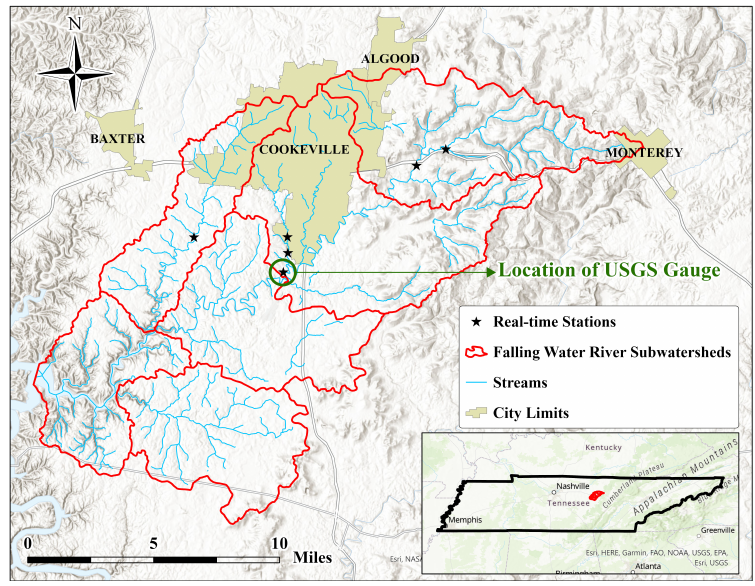
Figure 1. Falling Water River